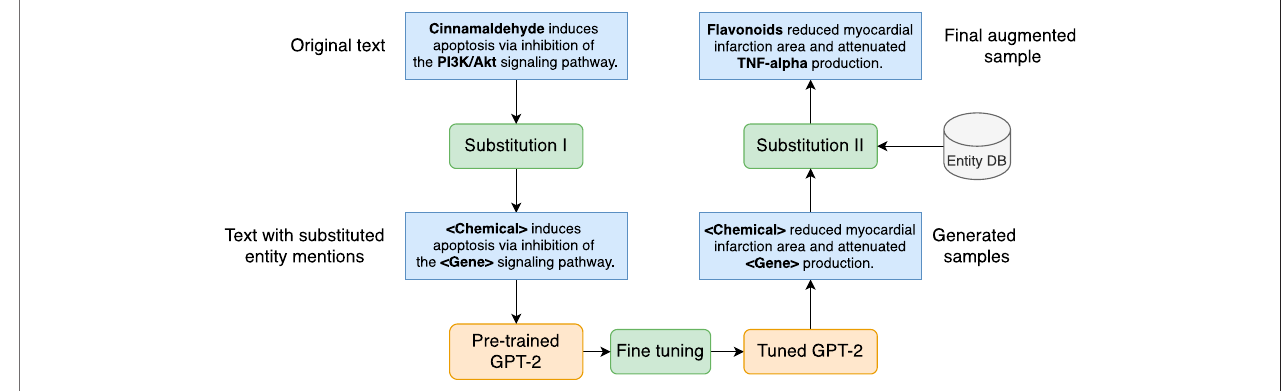
FIGURE 6 | Substitution-based generative model for data augmentation. Blue boxes refer to text samples, green rounded boxes are procedures, and orange rounded boxes are